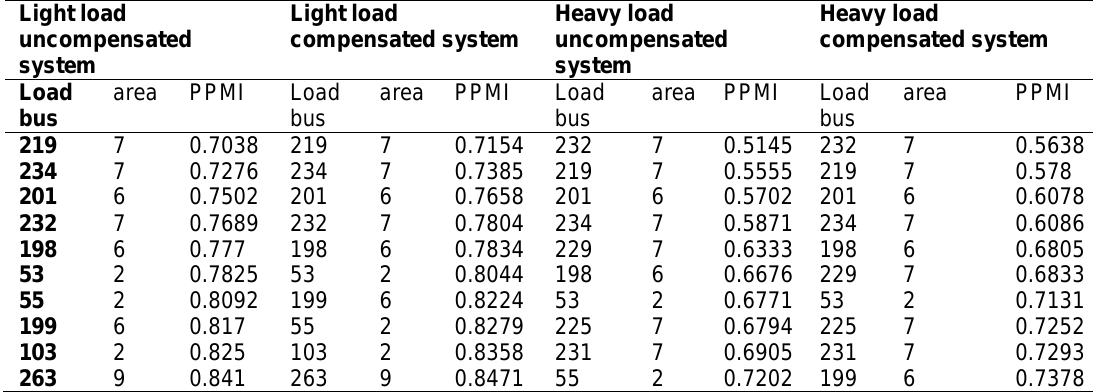
Table 4. Weakest buses under different system loading